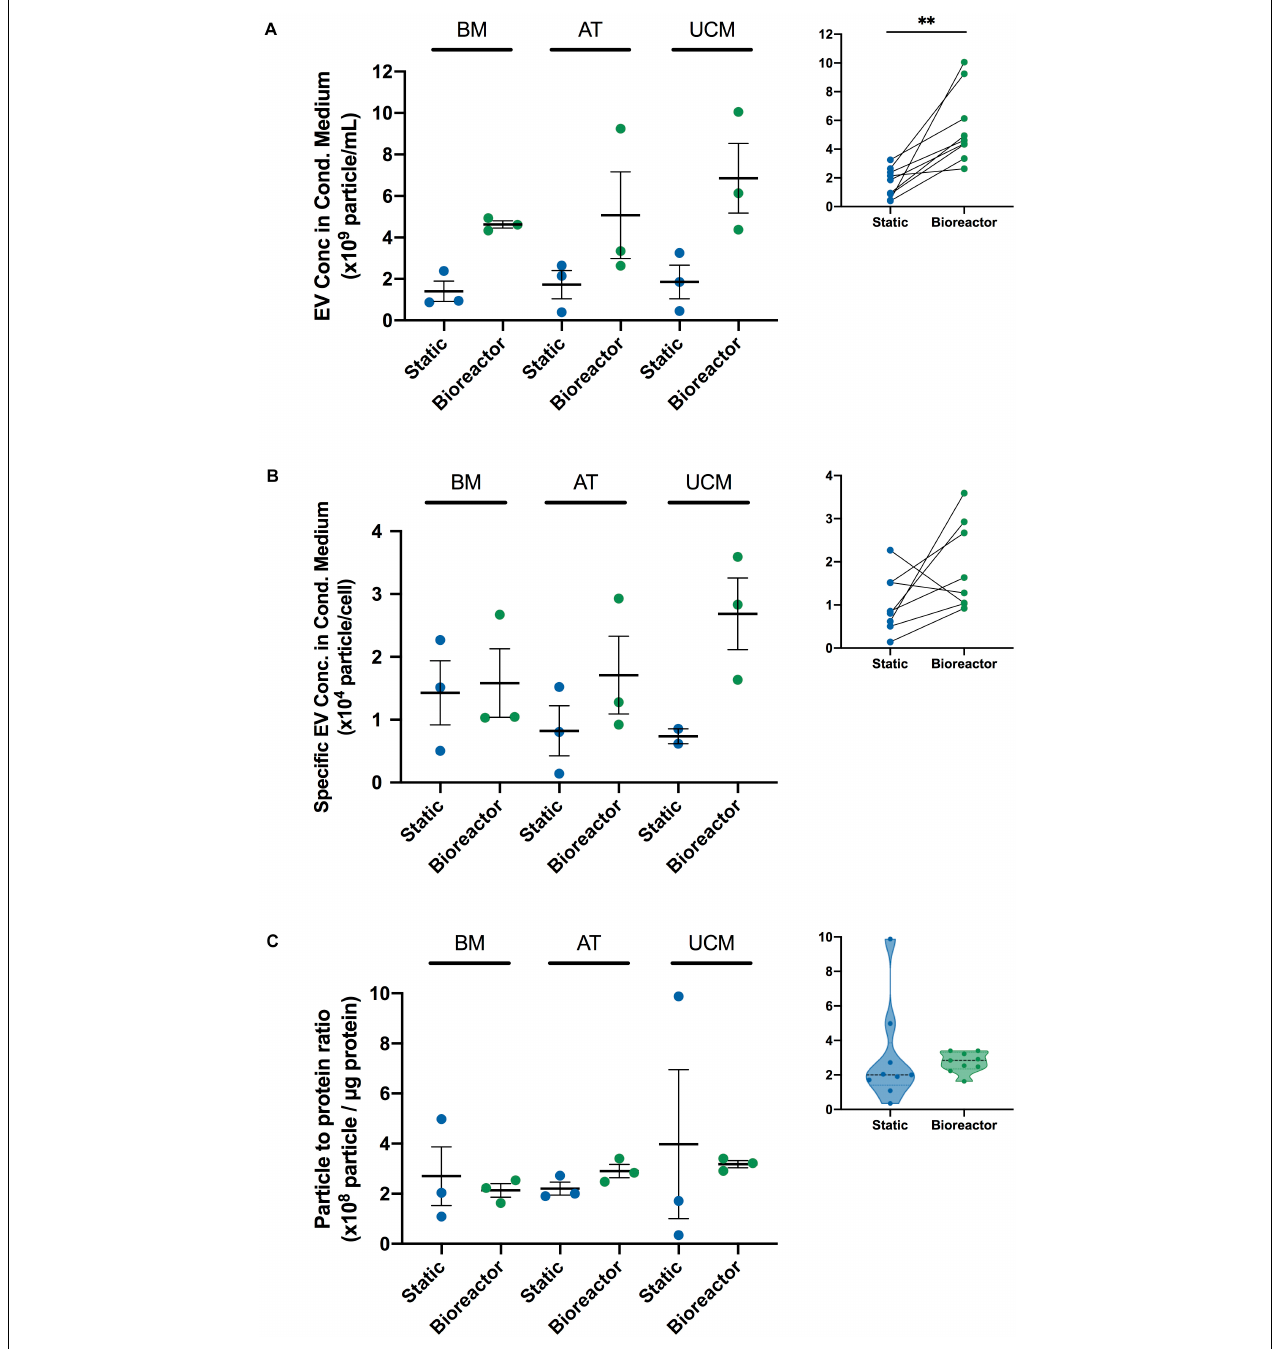
FIGURE 5 | Comparing MSC-EV production in bioreactor and static culture systems, using MSC from different sources. (A) EV concentration (particles/mL) in the cell culture conditioned medium from BM, AT, and UCM MSC cultures in static and Vertical-WheelTM bioreactor systems. MSC from three different donors were used for each tissue source (i.e., n = 3 biological replicates). Results are presented as mean ± SEM ( n = 3). Upper-right panel: Summarized paired analysis comparing EV concentration in static and Vertical-WheelTM bioreactor systems, for each MSC donor. Paired statistical analysis (paired t -test ∗∗ P = 0.0027) ( n = 9). (B) Specific EV concentration (particles/cell) in the cell culture conditioned medium from BM, AT, and UCM MSC cultures in static and Vertical-WheelTM bioreactor systems. MSC from three different donors were used for each tissue source. In static cultures, each T-175 yielded 1.2 – 6.6 × 10 6 cells upon 4 – 9 days of expansion, regardless of the cell tissue source. Results are presented as mean ± SEM ( n = 3; n = 2 for UCM-static). Upper-right panel: Summarized paired analysis comparing specific EV concentration in static and Vertical-WheelTM bioreactor systems, for each MSC donor. (C) Particle to protein ratios (PPR) (particle/ µ g protein) of EV samples obtained from BM, AT and UCM MSC, cultured in static and Vertical-WheelTM bioreactor systems. MSC from three different donors were used for each tissue source. Results are presented as mean ± SEM ( n = 3). Upper-right panel: Violin plot of PPR of MSC-EV samples obtained in static and Vertical-WheelTM bioreactor